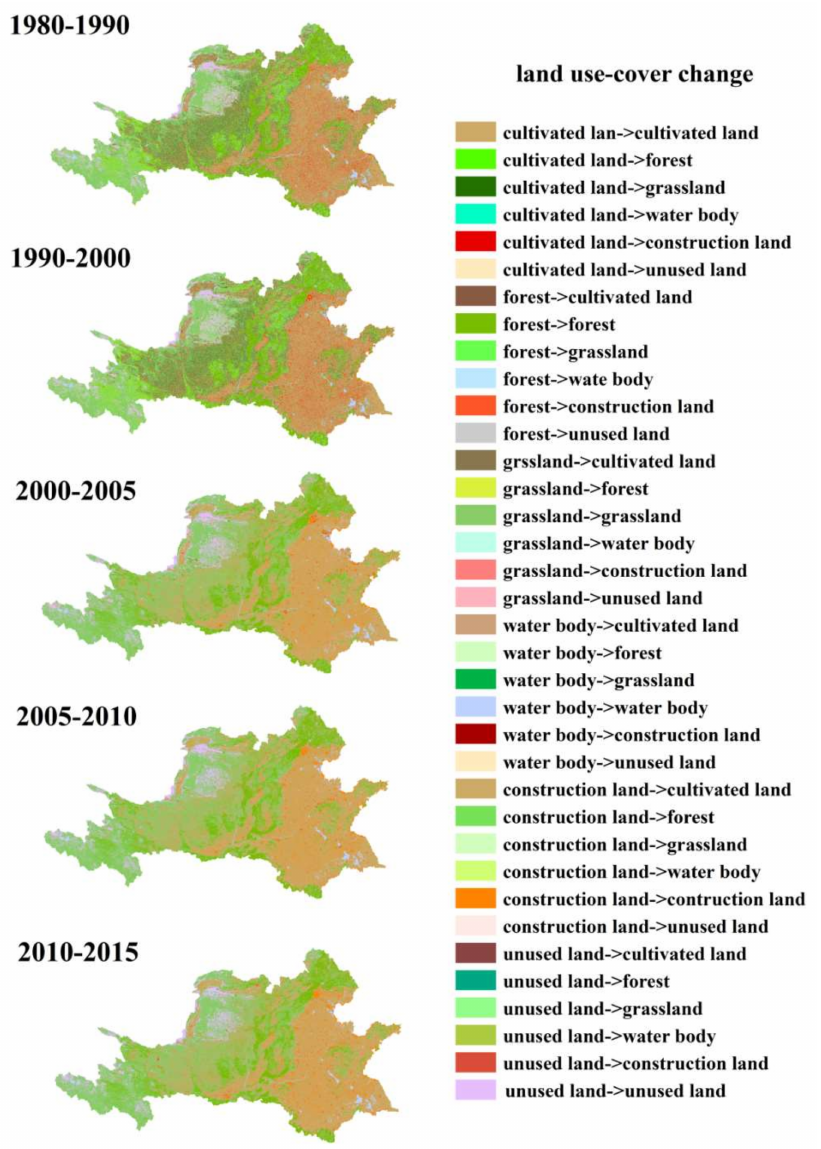
Figure 5. The spatial distribution of land use transfers in each period in the Huang-Huai-Hai River Basin from 1980 to